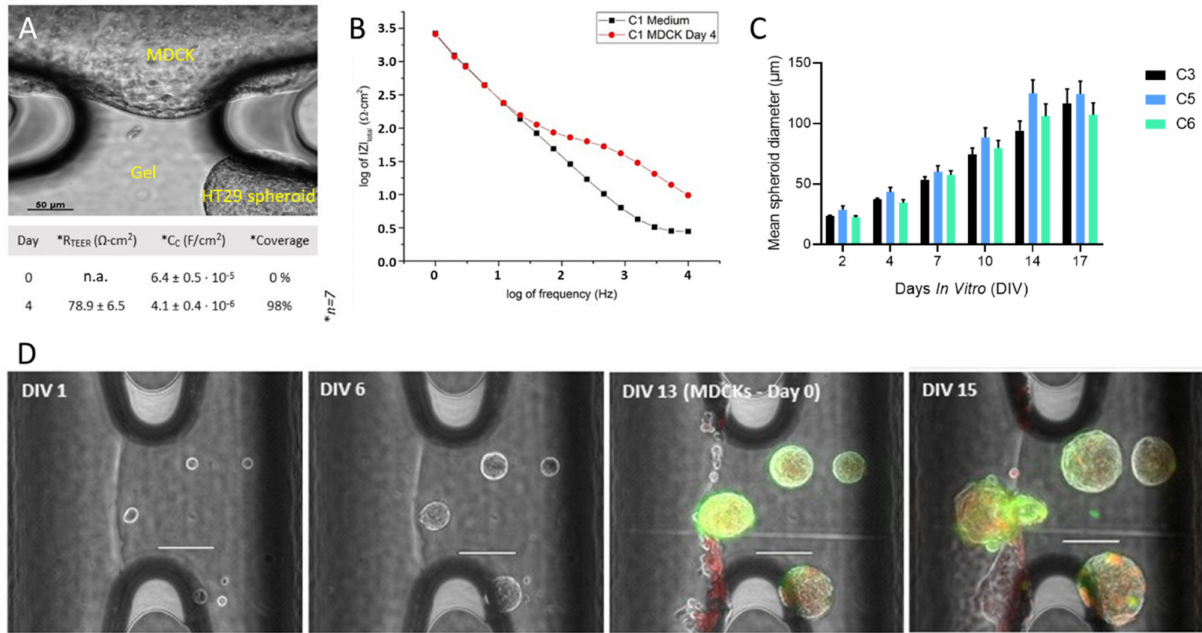
Figure 5. Co-culture of HT29 tumor spheroids with a cellular barrier of MDCK_VB6-CB cells. ( A ) Typical micrograph of culture area no. 1 showing the perfusion channel and gel interface between pillars completely lined by MDCK_VB6-CB cells and HT29 tumor spheroid growing in gel phase. An average TEER of 78.9 +/ − 6.5 Ω cm 2 at DIV4 was observed from n = 7 culture areas. The interfacial capacitance, C c , yielded an average coverage of 98%. ( B ) Typical impedance spectra of interface (culture area no. 1, corresponding to image in ( A ) without a cellular barrier (black dots) at day 0 and at day 4 of MDCK_VB6-CB cells (red dots), respectively. TEER: 58.7 Ω cm 2 ; lines represent the least square fit to data using the equivalent circuit display in Figure A2A. ( C ) Growth of HT29 tumor spheroids in three different channels during a period of 17 days, with 2 days under static conditions, and thereafter under continuous perfusion. Mean diameter of spheroids increased from 25 µ m to 120 µ m. Error bars indicate standard deviation calculated from n = 8 micro-spheroids. ( D ) Micrographs showing the growth of tumor spheroids in the gel phase under continuous perfusion, their interaction with a leaky cellular barrier of MDCK_VB6-CB cells (also labelled with CellTracker TM Red) and finally the outgrowth of a tumor spheroid into the perfusion channel at day